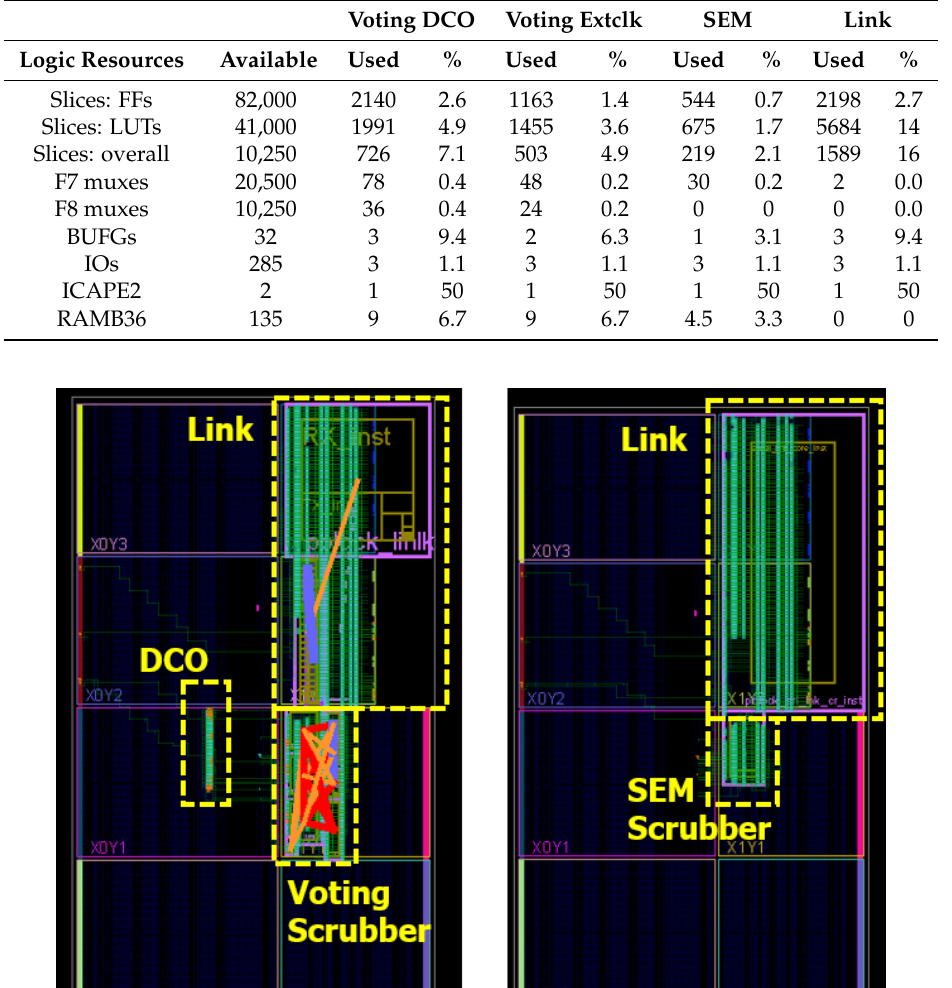
Table 1. Logic resources occupation for the tested scrubbers and the link node.